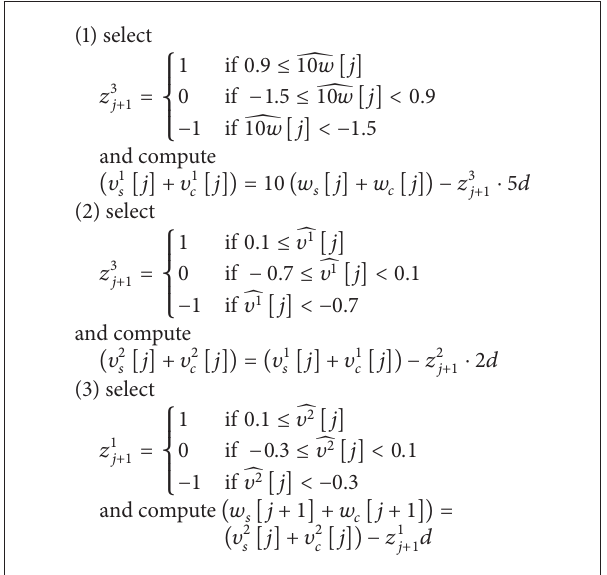
Algorithm 6: Pseudo code for the type 4 digit recurrence.